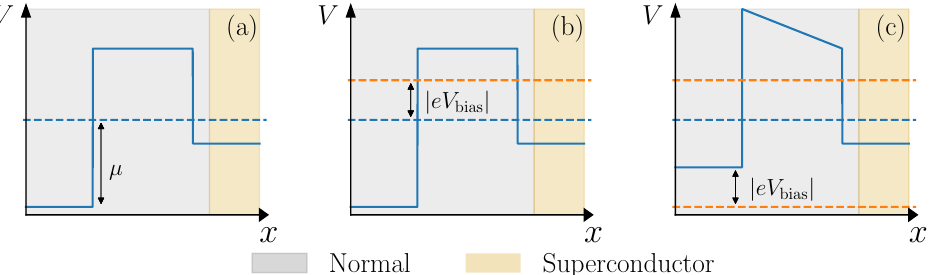
Figure 1: (a) Schematic band diagram of an NS tunnel junction at zero bias